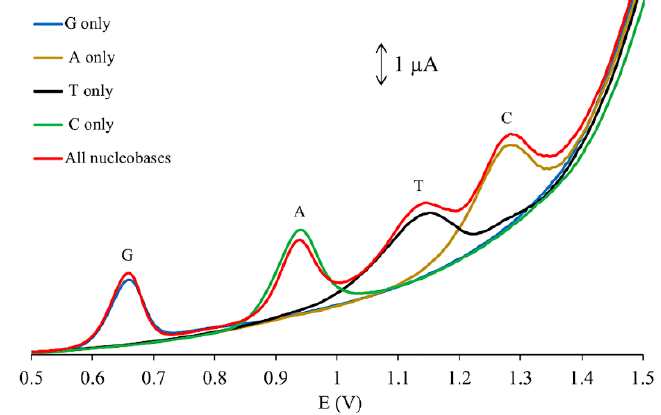
Figure 6. Overlay of DPV measurements using GCE / GO-MWCNT-CHT for individual detections and simultaneous detection of 12.5, 147.5, 97.5, and 10 μ M of A, T, C, and G in 0.2 M PBS (pH 7.0).